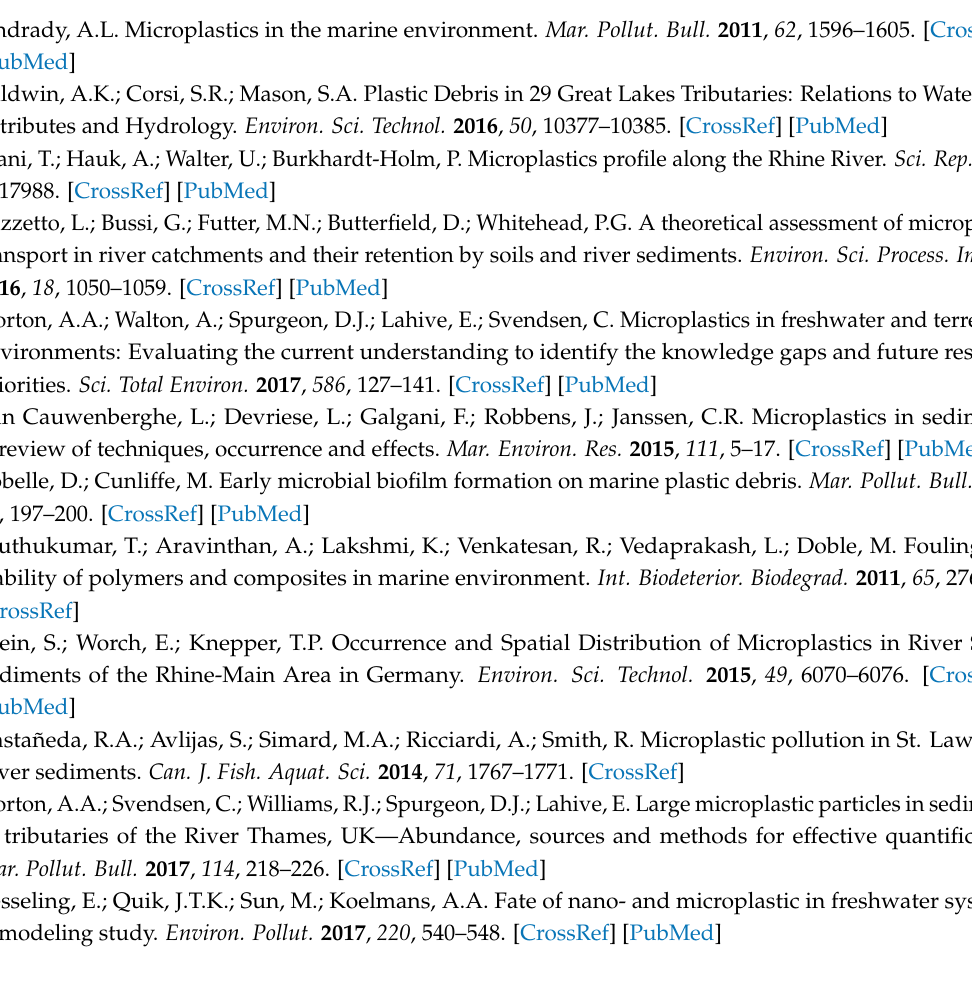
Figure S1: Degradation of phenanthrene, Table S1: ANOSIM R Values of the treatment with microplastic of sediment collected downstream of a WWTP, Table S2: ANOSIM R Values of the treatment with microplastic of sediment collected at the river spring, Table S3: ANOSIM R Values of the treatment with phenanthrene and microplastic of sediment collected downstream of a WWTP, Table S4: ANOSIM R Values of the treatment with phenanthrene and microplastic of sediment collected at the river spring, Table S5: ANOSIM R Values of the treatment with anthracene and microplastic of sediment collected downstream of a WWT, Table S6: ANOSIM R Values of the treatment with anthracene and microplastic of sediment collected at the river spring, Table S7: Bonferroni multiple comparison post-test on the one-way ANOVA for differences between treatments in anthracene concentrations of the spring